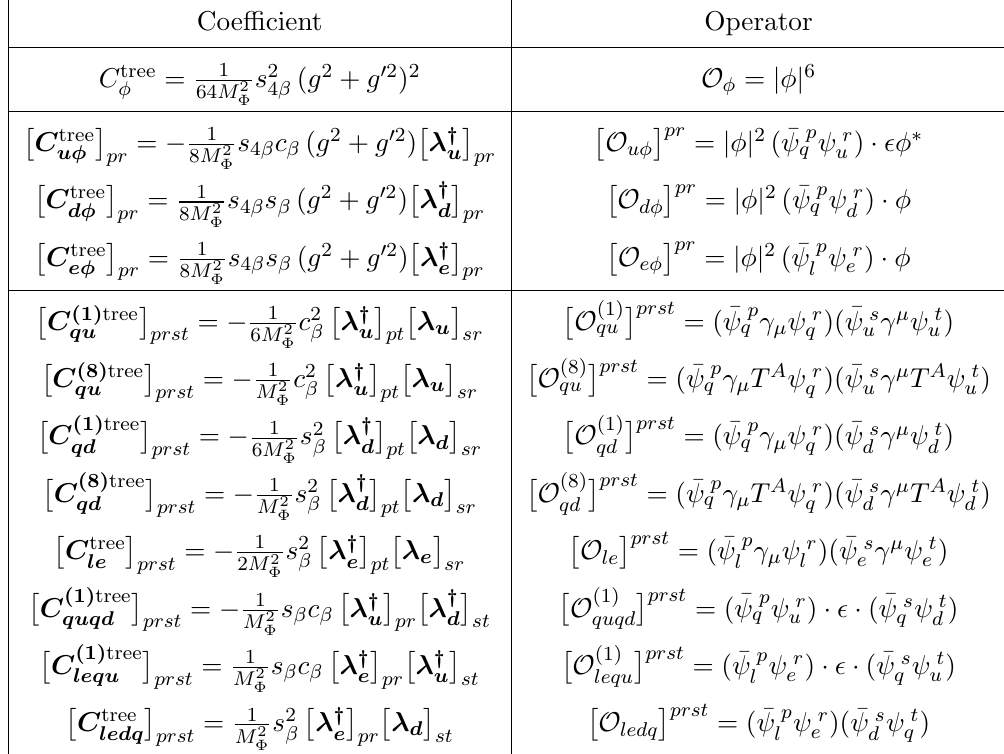
Table 5 . Dimension-six operators generated at tree level when matching the MSSM onto the SMEFT. p; r; s; t are generation indices. Tree-level matching alone produces the operator coe(cid:14)cients listed here, but with (cid:12) 0 in place of (cid:12) . As explained in section 3.2.1, adding the one-loop-generated piece c (cid:8) (cid:30) ((cid:8) (cid:3) (cid:30) + (cid:30) (cid:3) (cid:8) c ) to L tree amounts to replacing (cid:12) 0 by (cid:12) in all C tree c i SMEFT